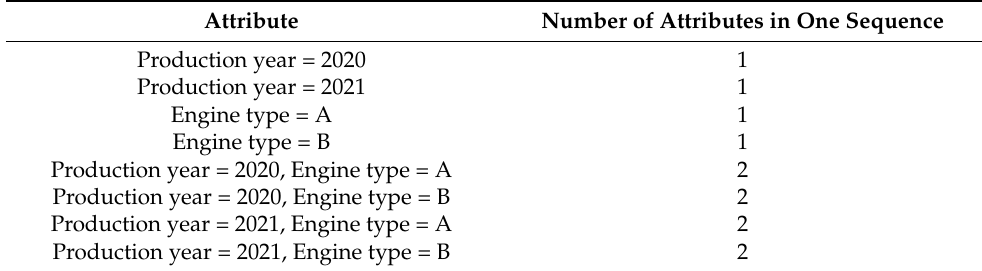
Table 4. Possible attributes of objects with one attribute or both attributes. Attribute Number of Attributes in One